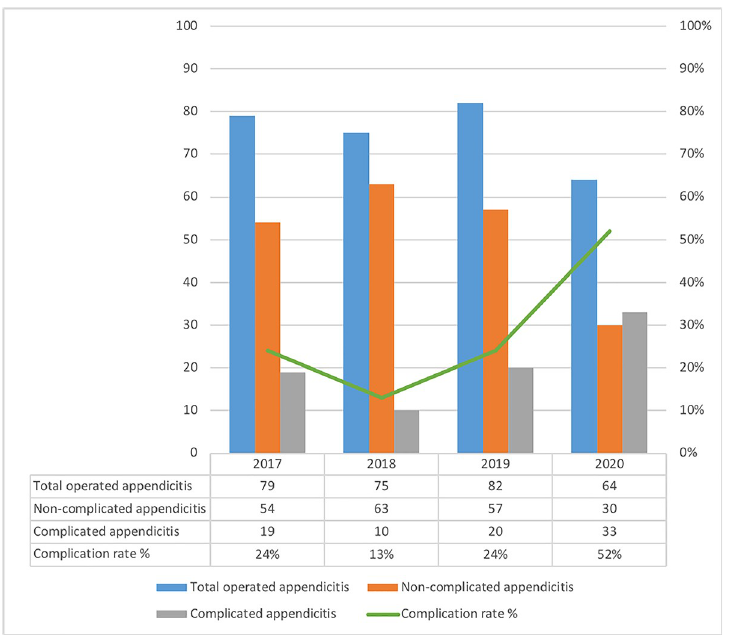
Fig 1. Distribution of complicated and non-complicated appendicitis. Distribution of non-complicated and complicated appendicitis based on the laparoscopic grading score. Normal-looking appendix is not included in the